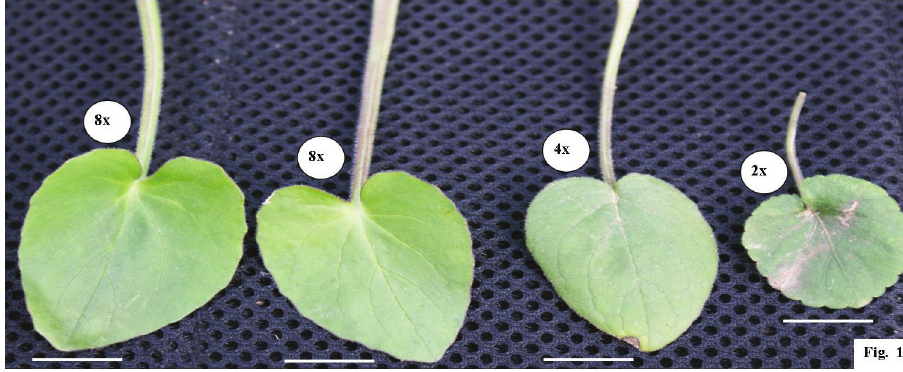
Figure 1. Leaves showing variations among 2x, 4x and 8x cytotypes of Valeriana jatamansi . the altitude of 764–2236 m in the state. The octaploid cytotypes are restricted only to higher altitude localities (3,164–3,647 m) in Kullu district of Himachal Pradesh.